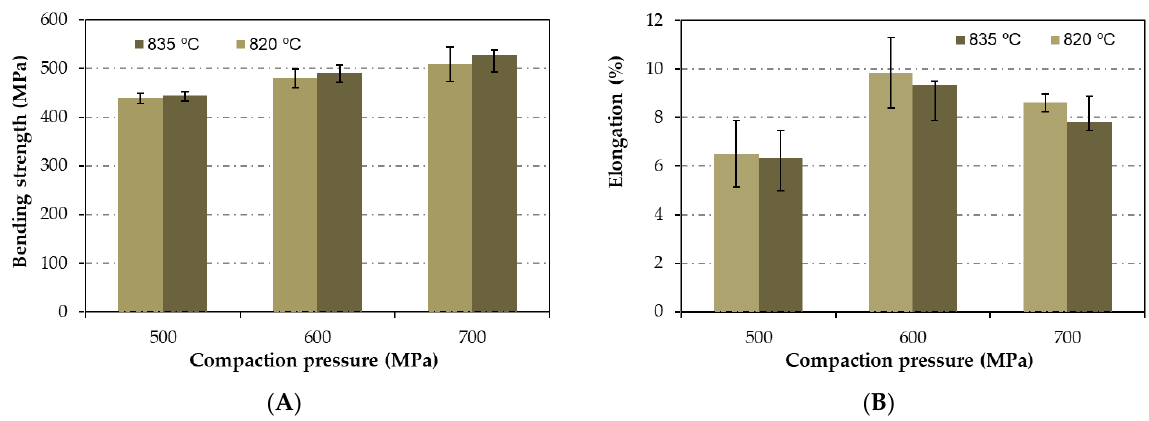
Figure 8. ( A ) Bending strength and ( B ) elongation at low temperatures sintering versus compaction pressure.